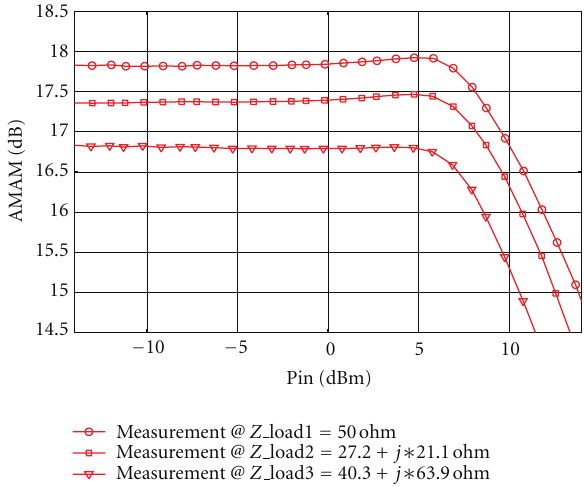
Figure 18: Phase modulation (AMPM) versus input power for several loading impedances (Z load1 = 50 ohms, Z load2 = 27 . 2 + j · 21 . 1, Z load3 = 40 . 3 + j · 63 .